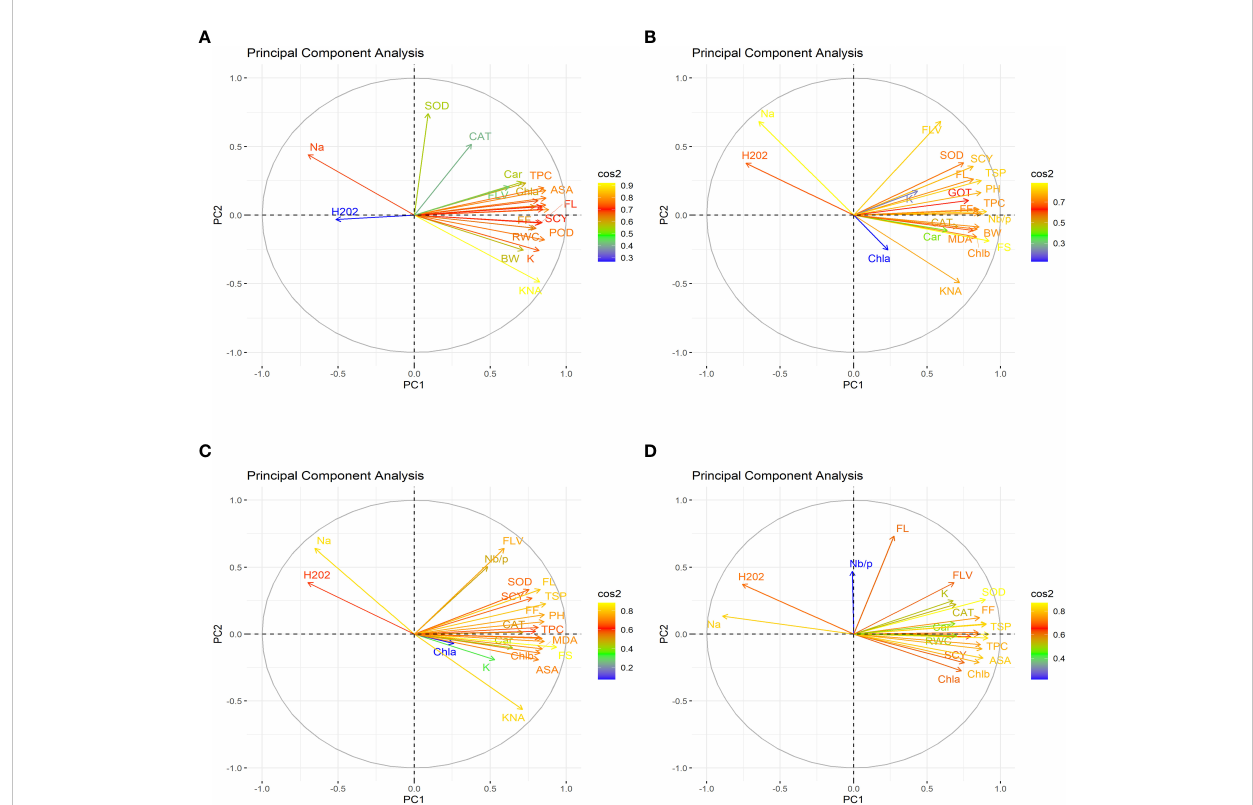
FIGURE 3 First year heat map analysis based on mean values of various agro-physiological, biochemical, and fi ber quality traits of 30 cotton genotypes (A) control, (B) drought stress (D) , (C) heat stress (H), and (D) drought + heat stress (DH). ASA, ascorbic acid; BW, boll weight; CAR, carotenoids; CAT, catalase; Chla, Chlorophyll a; Chlb, Chlorophyll b; FF, fi ber fi neness; FL, fi ber length; FLV, fl avonoids; FS, fi ber strength; GOT, ginning out turn percentage; H202, Hydrogen peroxide; K+, potassium content; K+/Na+, the potassium over sodium ratio; MDA, malondialdehyde; Na+, the sodium contents; NBP, Number of bolls per plant; PH, plant height; POD, peroxidase; RWC, Relative water content; SCY, seed cotton yield; SOD, superoxide dismutase; TPC, total phenolic content; TSP, total soluble